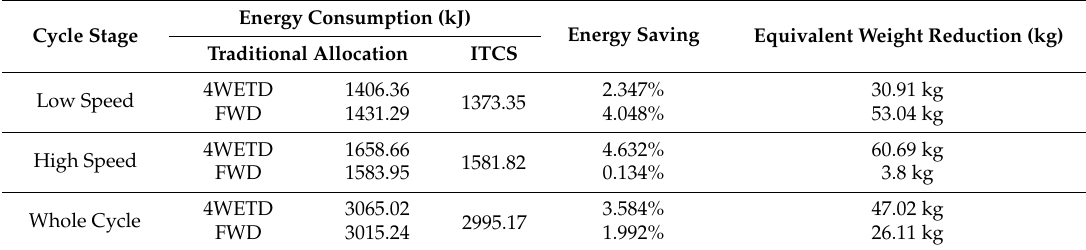
Table 3. Improvement analysis among different traction allocation strategies. ITCS: integrated traction control strategy; 4WETD: four-wheel even torque drive; and FWD: front-wheel-drive. Energy Consumption (kJ) Energy Saving Equivalent Weight Reduction (kg) Cycle Stage Traditional